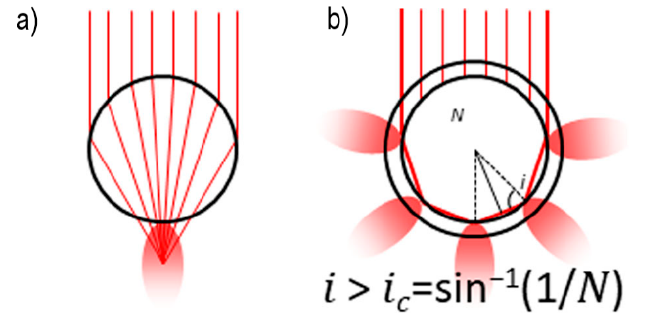
Figure 10. Non-plasmonic electromagnetic enhancement in dielectric nanoparticles. ( a ) A dielectric sphere acts as a microlens, focusing light; ( b ) in a core-shell dielectric resonator, light is partially trapped inside the core. The Raman signal is amplified by the evanescent waves generated at the surface of the core. Reproduced with permission from Bontempi et al. [205]. Copyright (2018), John Wiley and